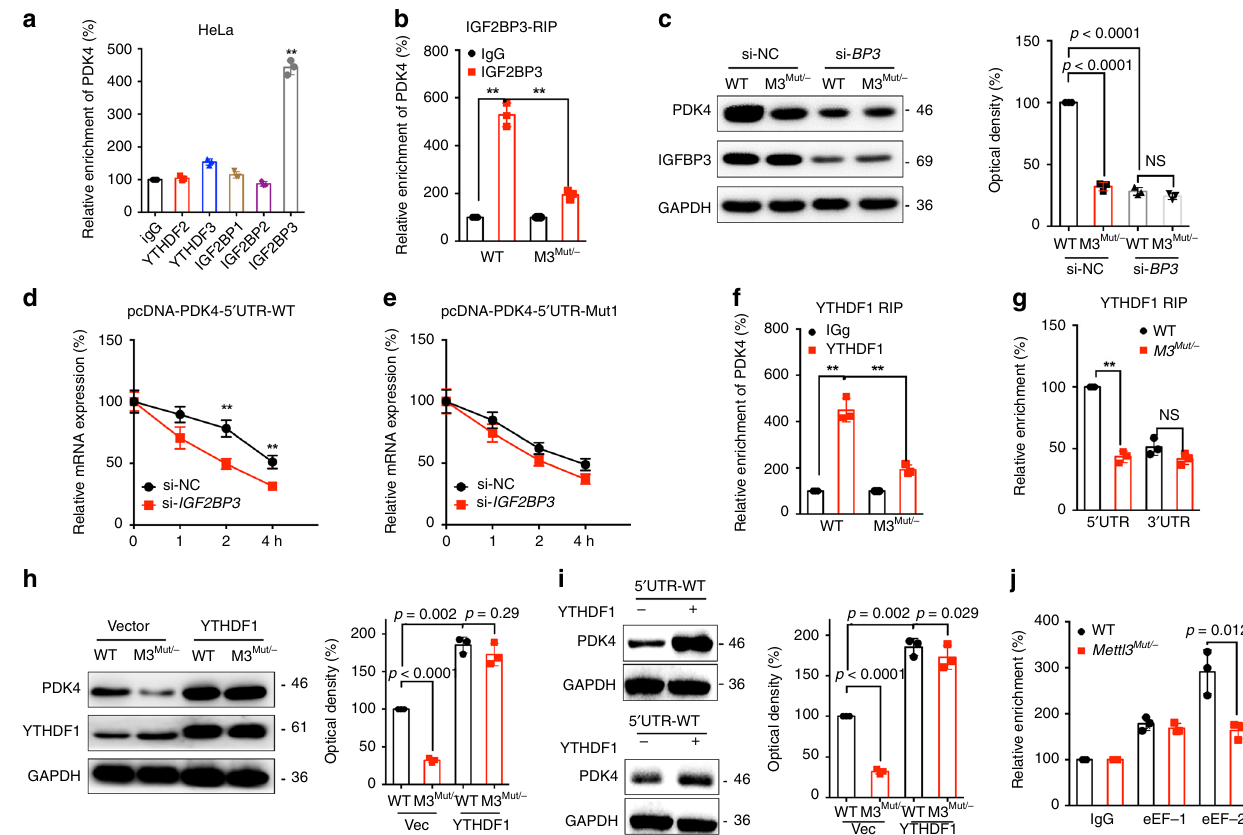
Fig. 5 Factors involved in m 6 A regulated expression of PDK4. a RIP-qPCR analysis of PDK4 mRNA in wild type HeLa cells by use of antibody of YTHDF2, YTHDF3, and IGF2BP1~3. b IGF2BP3 RIP-qPCR analysis of PDK4 mRNA in wild type or Mettl3 Mut/- HeLa cells. c Wild type or Mettl3 Mut/- HeLa cells were transfected with si-NC or si-IGF2BP3 for 24 h, the expression of PDK4 was checked by western blot analysis (left) and quantitatively analyzed (right). d , e HeLa cells were transfected with si-NC, si-IGF2BP3, pcDNA-PDK4-5 ′ UTR-WT ( d ) or pcDNA-PDK4-5 ′ UTR-Mut1 ( e ) for 24 h and then further treated with Act-D for the indicated times. The mRNA of PDK4 was checked by qRT-PCR. f YTHDF1 RIP-qPCR analysis of PDK4 mRNA in wild type or Mettl3 Mut/- HeLa cells. g Binding of YTHDF1 with the 5 ′ UTR or 3 ′ UTR in wild type or Mettl3 Mut/- HeLa cells were analyzed by YTHDF1 RIP-qPCR using fragmented RNA. h Wild type or Mettl3 Mut/- HeLa cells were transfected with vector or YTHDF1 construct for 24 h, the expression of PDK4 was checked by western blot analysis (left) and quantitatively analyzed (right). i HeLa cells were transfected with vector, YTHDF1 construct, pcDNA-PDK4-5 ′ UTR-WT, and pcDNA-PDK4-5 ′ UTR-Mut1 for 24 h, the expression of PDK4 was checked by western blot analysis (left) and quantitatively analyzed (right). j eEF-1 and eEF-2 RIP-qPCR analysis of PDK4 mRNA in wild type or Mettl3 Mut/- HeLa cells. Data are presented as the mean ± SD from three independent experiments. * p < 0.05, ** p < 0.01, NS, no signi fi cant, by two-tailed unpaired Student ’ s t test for ( a ) ( p < 0.0001) and ( g ) ( p < 0.0001 and p = 0.11, respectively), and two-way ANOVA for ( b ) ( p < 0.0001 and p = 0.004, respectively), ( c , d ) ( p < 0.0001 for all), ( f ) ( p = 0.0003 and p = 0.001, respectively), ( h – j (Supplementary Fig. 6B) or gRNAs combined with dCas13b (Supplementary Fig. 6C) had no signi fi cant change. The demethylation effect of dm 6 ACRISPR on PDK4 mRNA